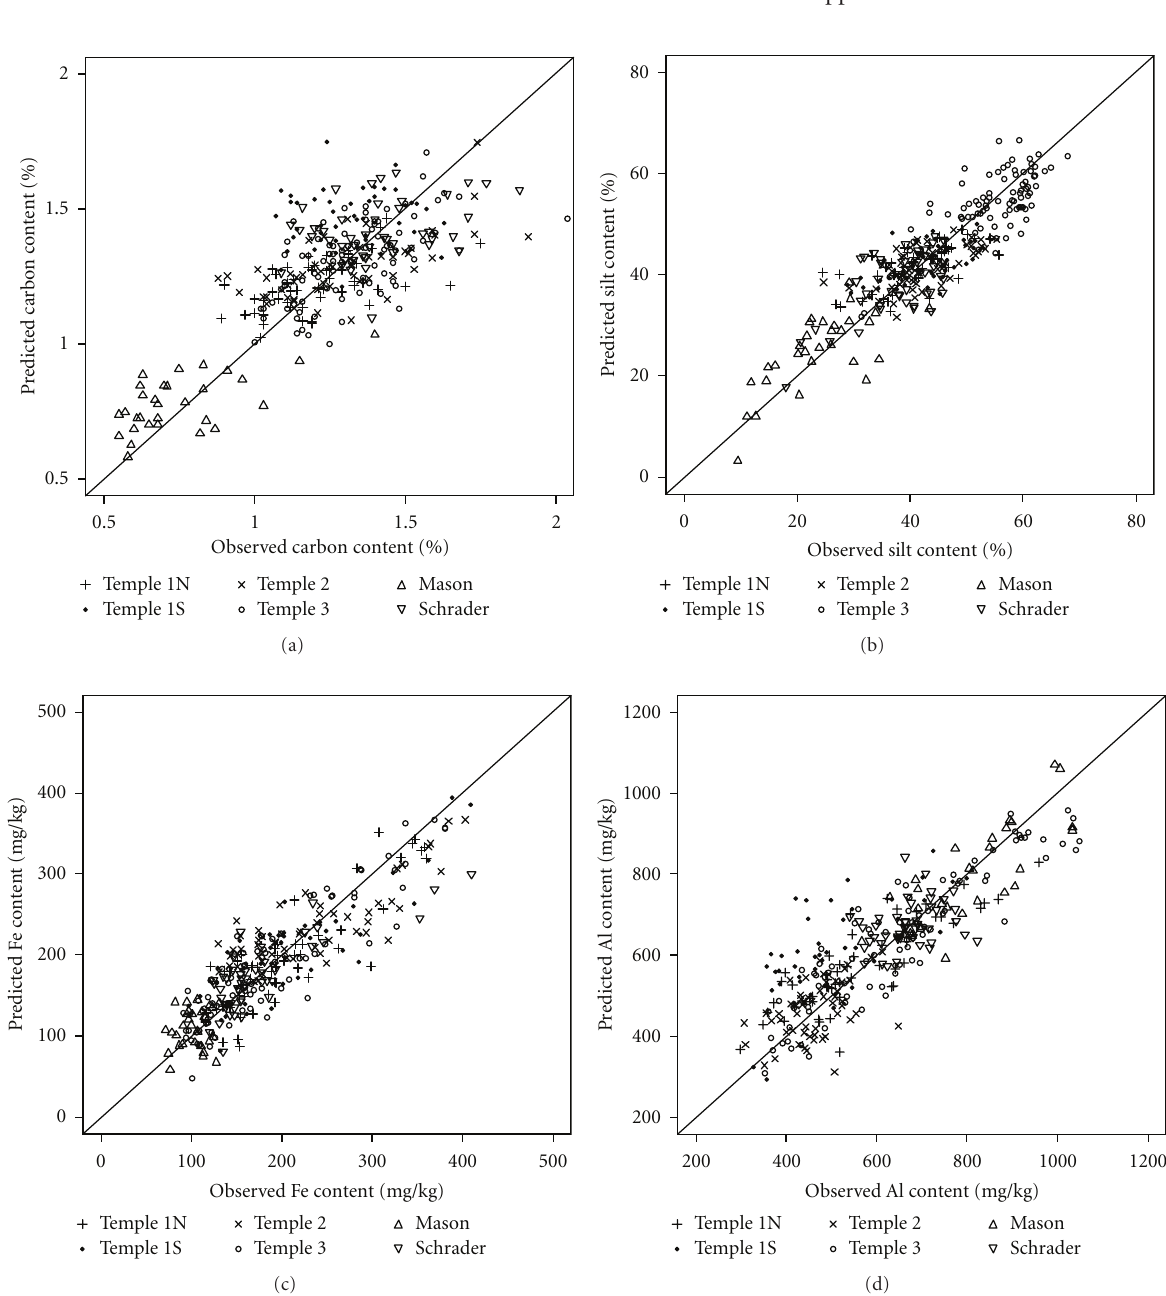
Figure 2: Comparison of observed analyte concentrations with values predicted using partial least squares (PLS) regression on reflectance spectra extracted from smoothed imagery to which a 3 × 3 low-pass filter had been applied, for (a) soil carbon, (b) silt, (c) iron, and (d) aluminum content. The field containing 41 sampling points that were left out for validation (Temple 1S) is depicted with solid